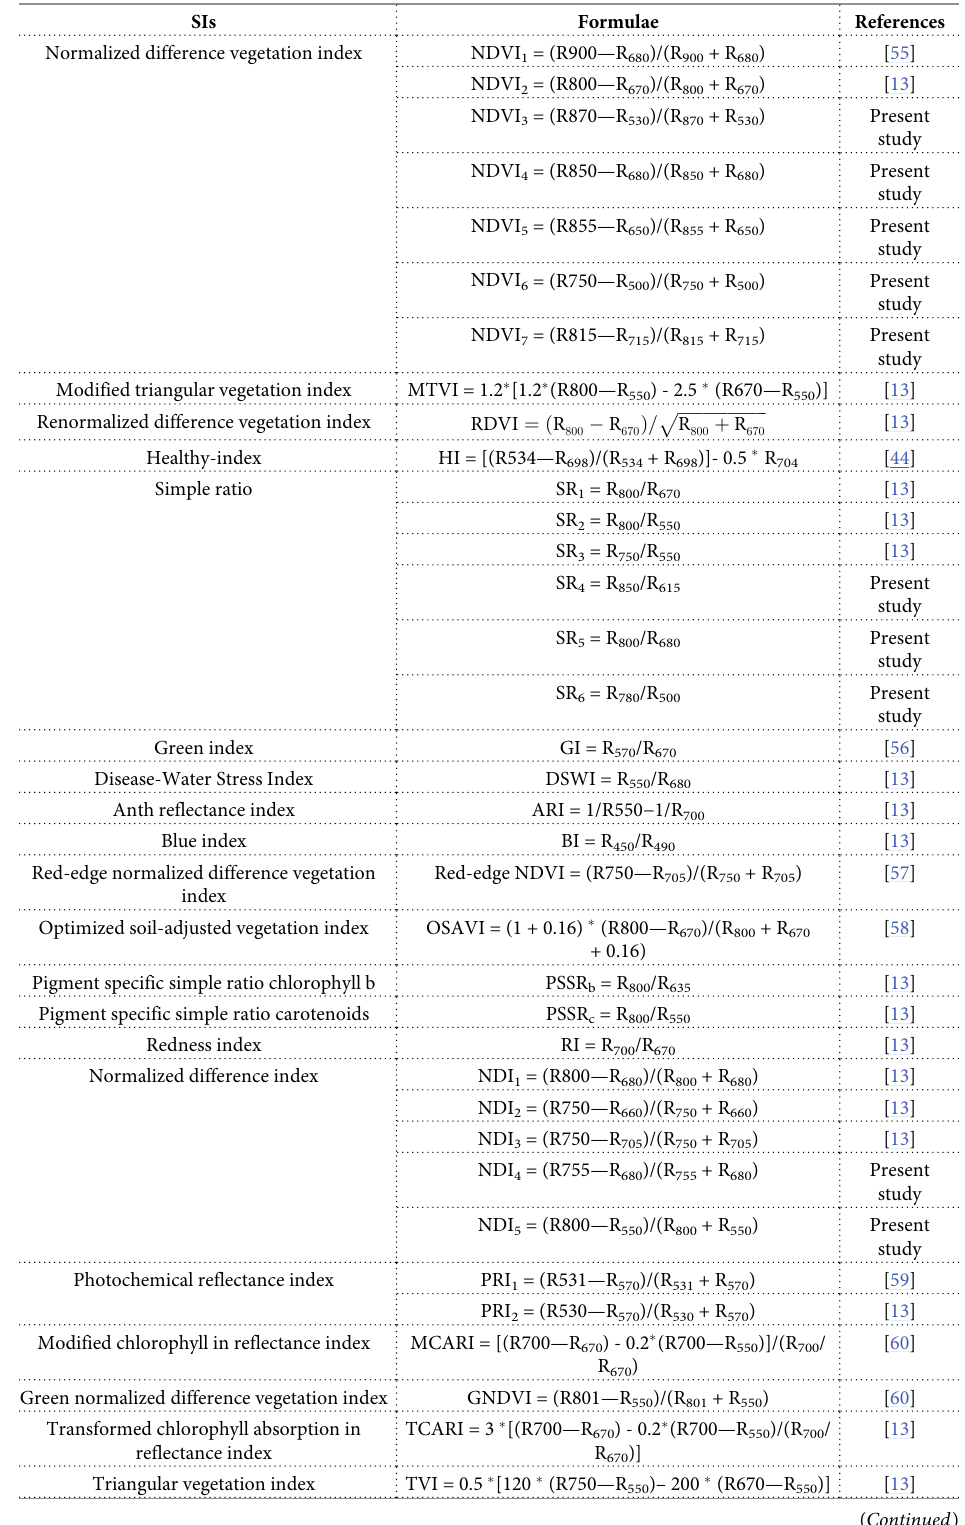
Table 1. List of spectral indices cited in previous literature and developed in this